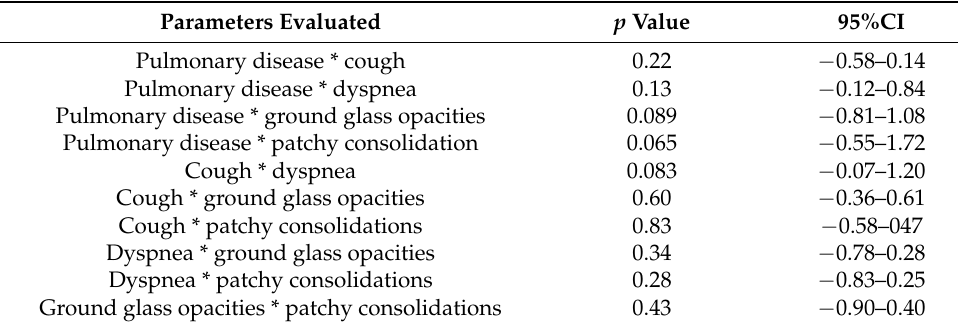
Table 6. An interaction analysis between the symptoms and imaging findings included in the multivariate analysis.